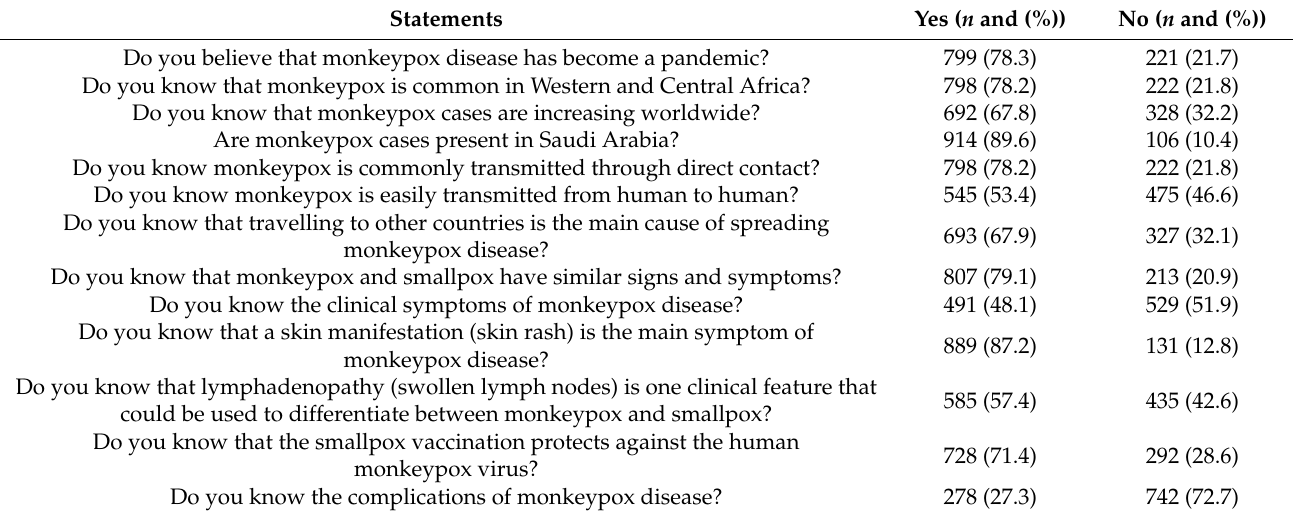
Table 2. Participants’ awareness of the monkeypox virus and disease.